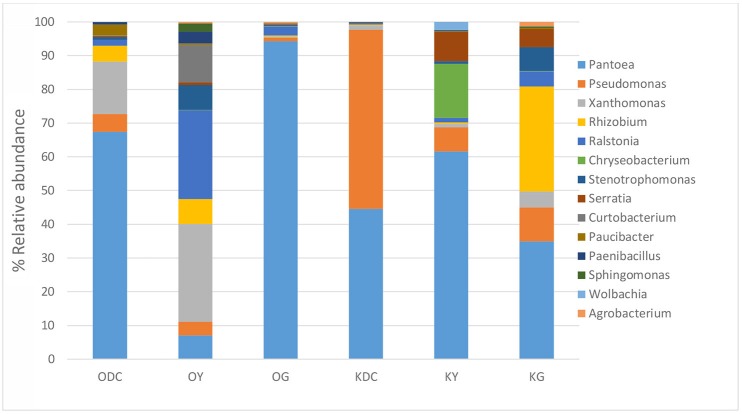
Analysis of culture-independent stem endophytic communities at genus level isolated from plants growing in hydrocarbon contaminated (sample name starts with O for Oil Spring) and non-hydrocarbon contaminated soils (sample name starts with K for Komoka)—ODC, Oil Spring Daucus carota; OY, Oil Spring yarrow (A. millefolium); OG, Oil Spring goldenrod (S. canadensis); KDC, Komoka Daucus carota; KY, Komoka yarrow; KG, Komoka goldenrod.